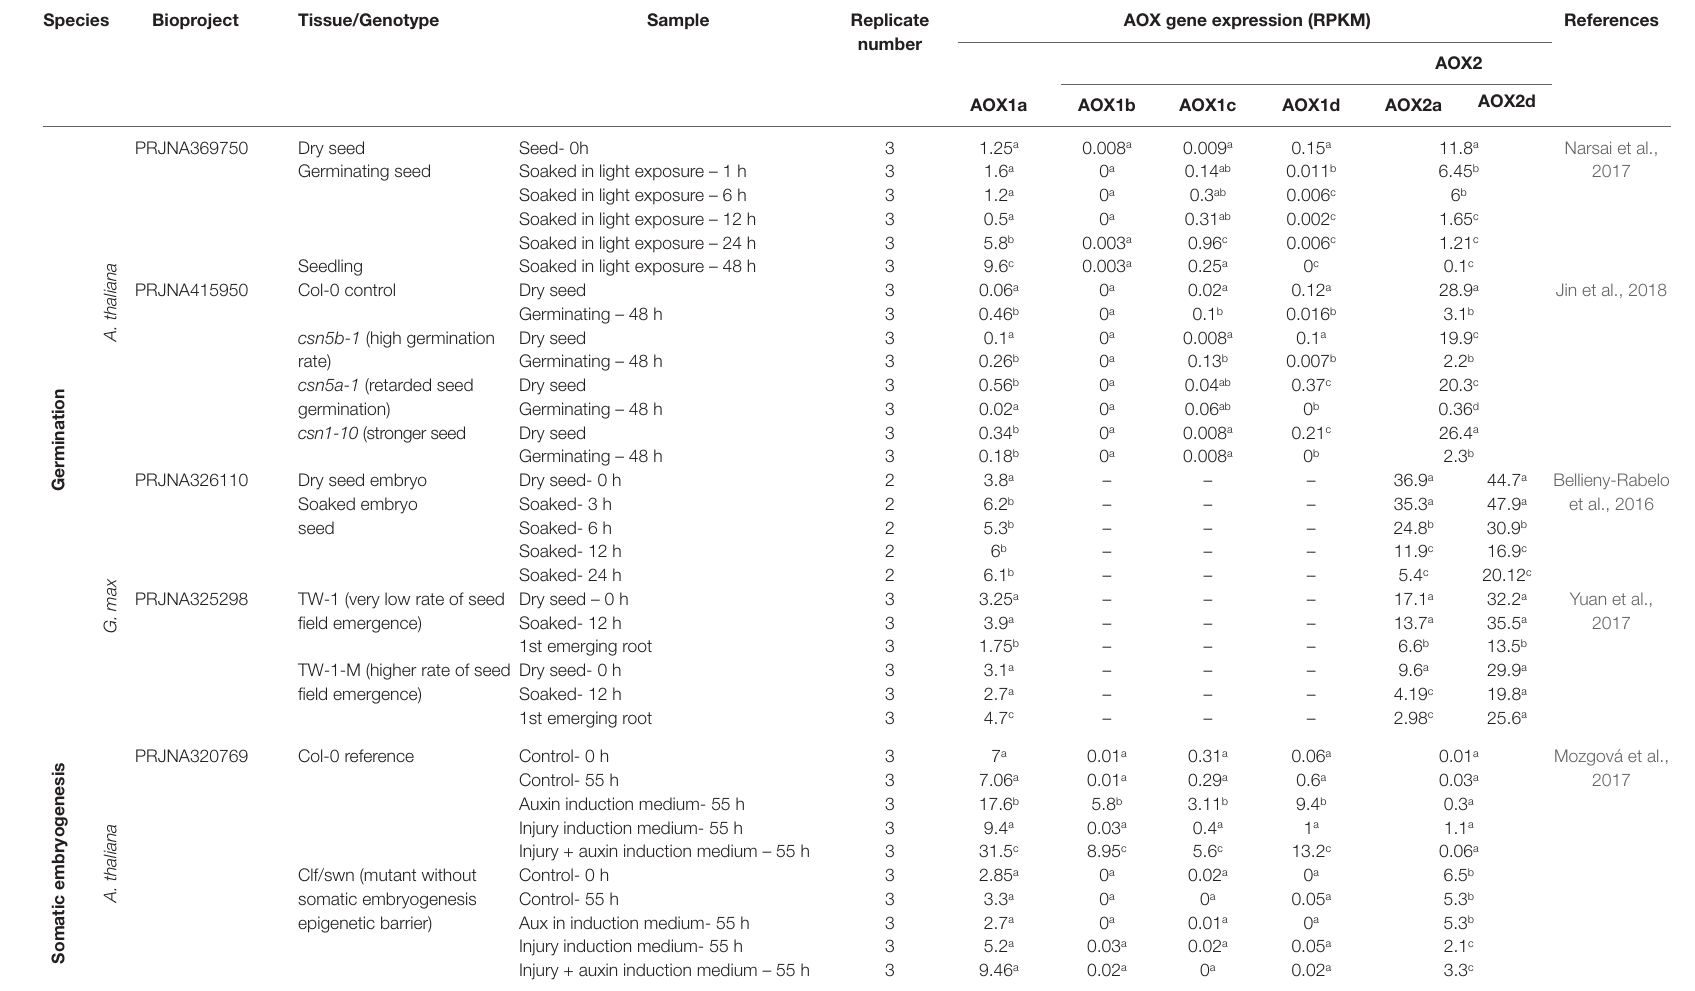
TABLE 1 | Expression of AOX genes during germination ( Arabidopsis and soybean) and somatic embryogenesis ( Arabidopsis ) using RNA-seq